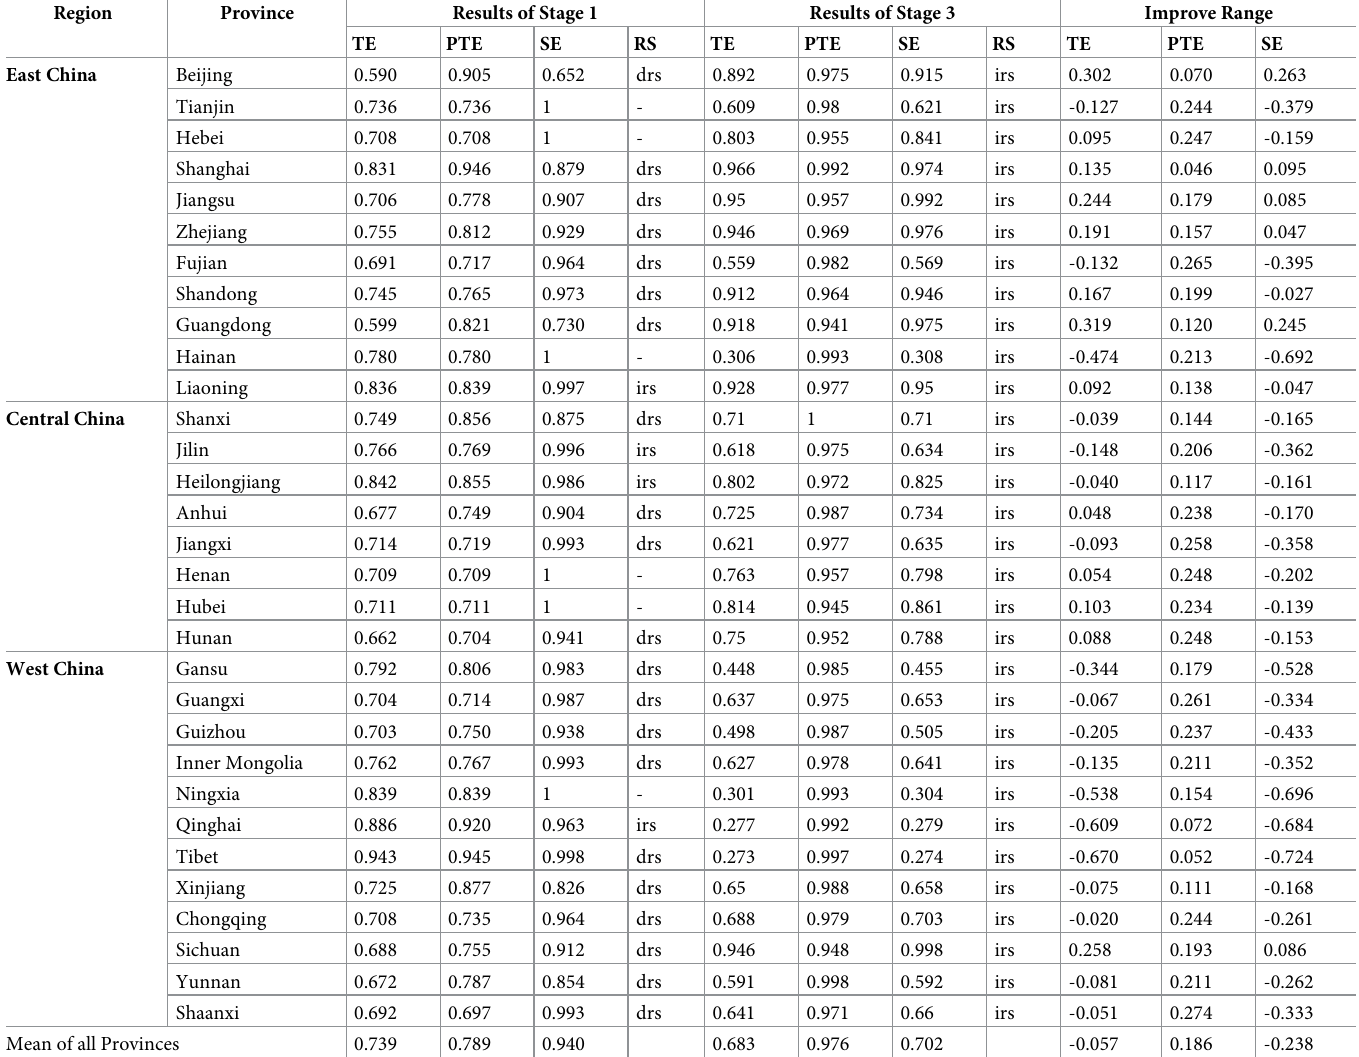
Table 5. Measurement results and comparison table of Stage 1 and Stage